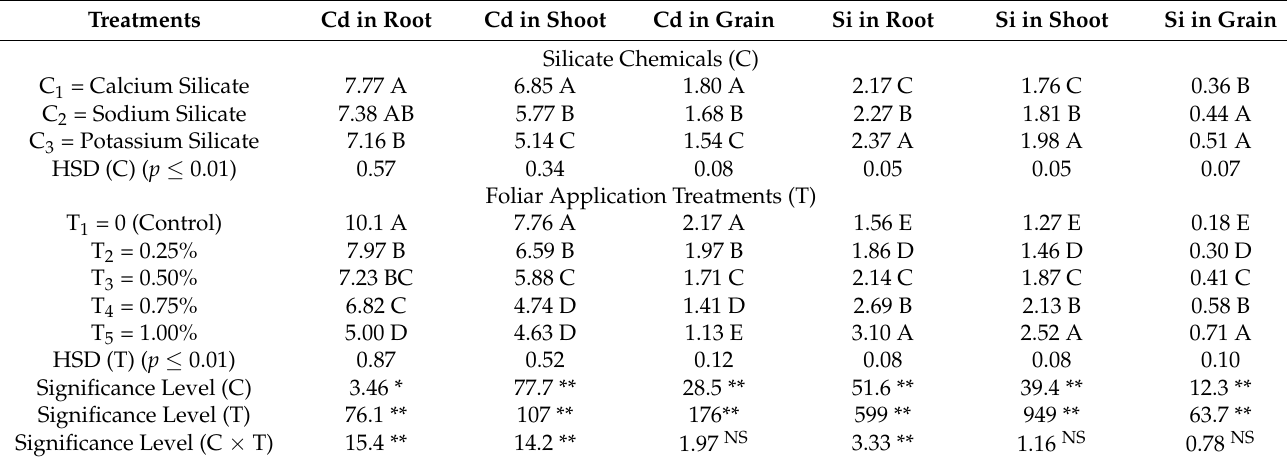
Table 3. Effect of silicate chemicals, with various doses of foliar applications, on the Cd and Si contents (mg kg − 1 ) in rice organs grown in Cd-contaminated soil.